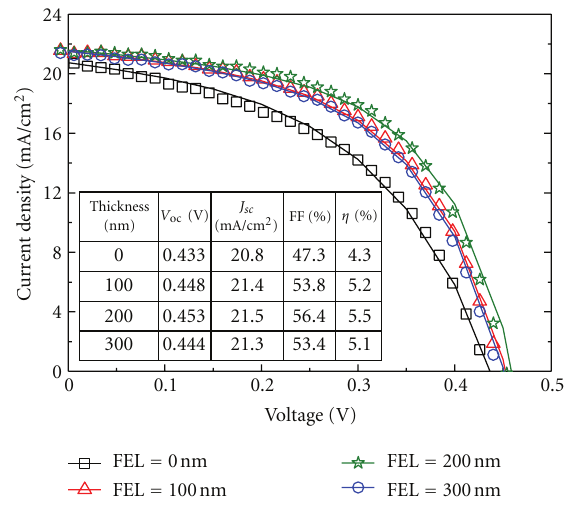
Figure 3: J - V measurements of μ c-Si 0 . 9 Ge 0 . 1 :H solar cells with μ c- Si:H FEL varied from 0 to